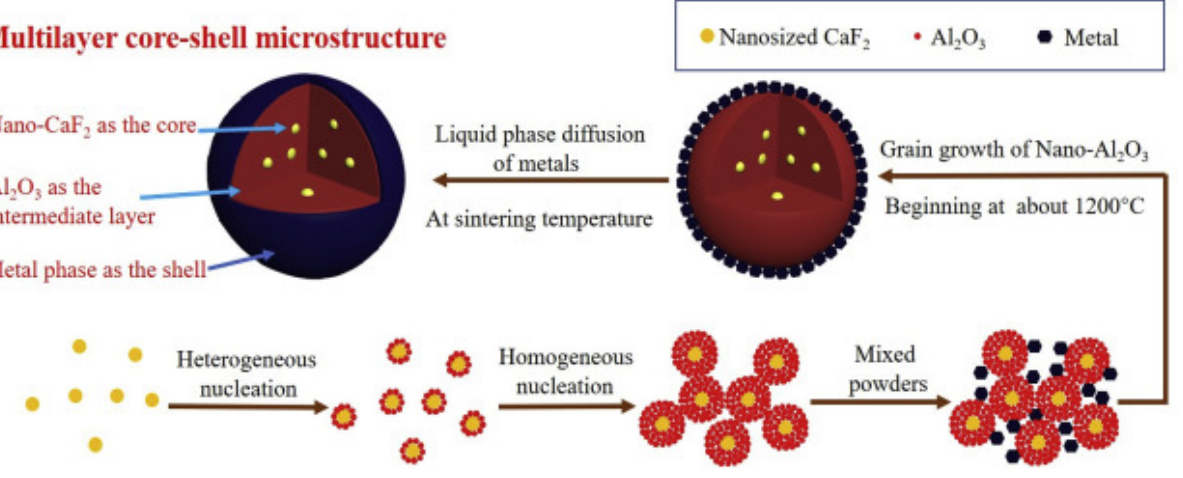
Figure 7. Formation of multilayer core-shell microstructure of TiCN-based cermet system. Reprinted with permission from Ref. [52]. Copyright 2020 Elsevier.